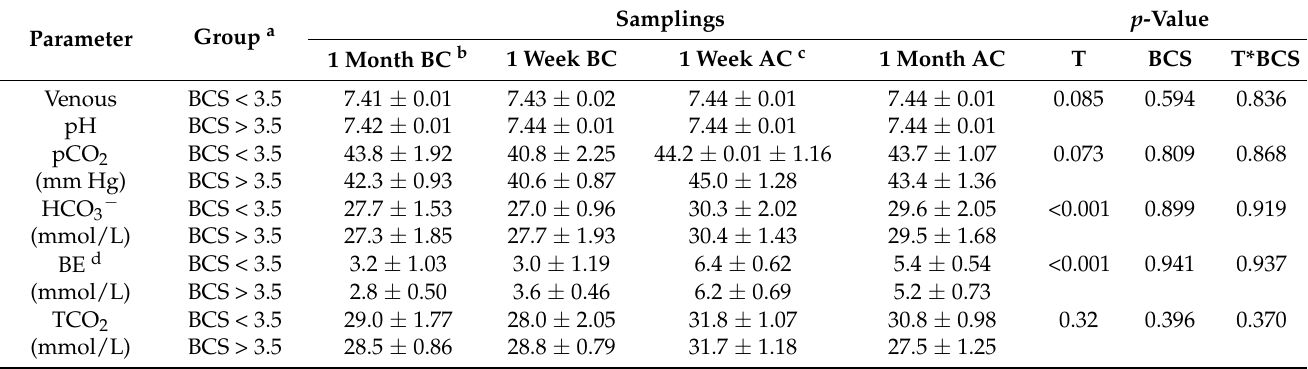
Table 3. Mean values ( ± standard error of the mean, SEM) of acid–base parameters depending on BCS group during the study period. Parameter Group a